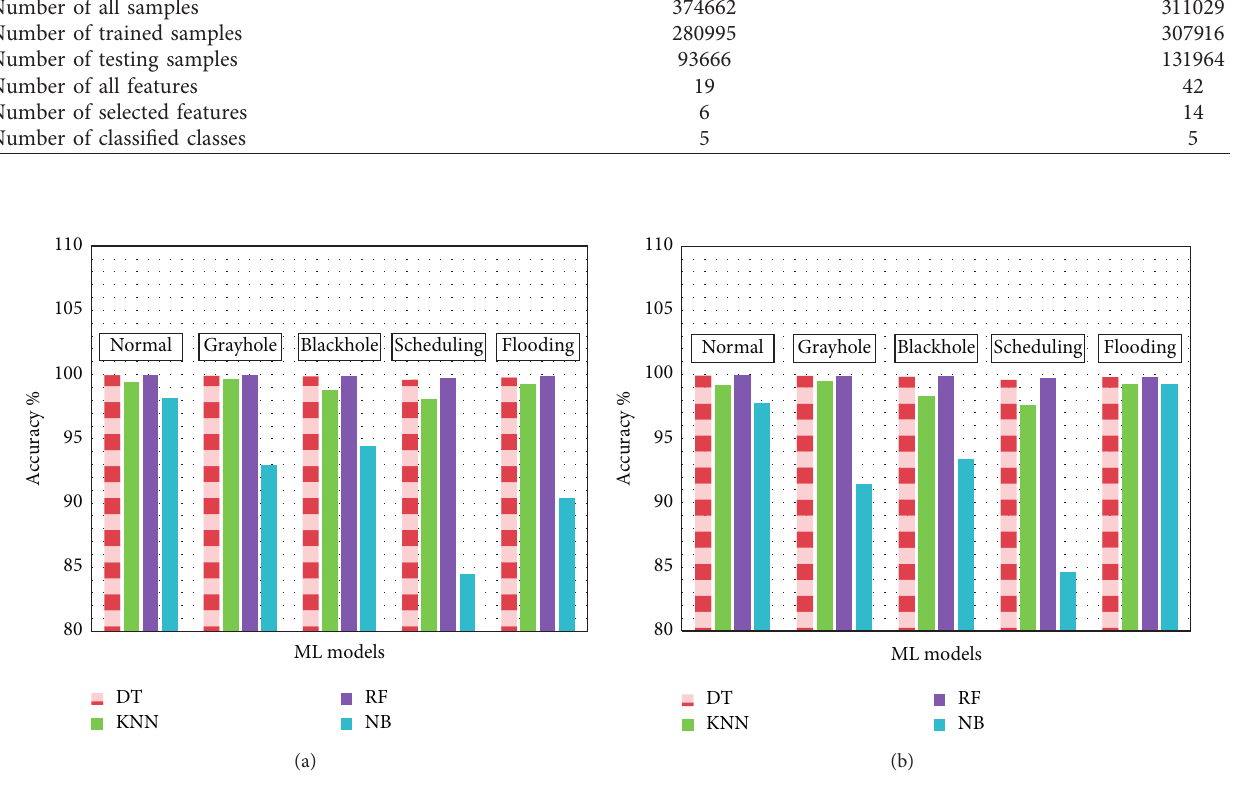
Figure 3: The results of machine learning cross-validation performance for the WSN dataset: (a) accuracy using all features and (b) accuracy using selected